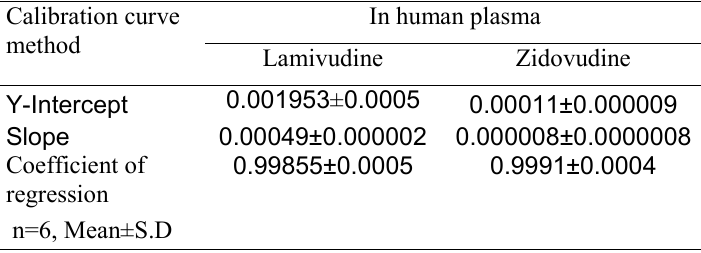
Figure 2. Spectrum for plasma interference with samples and standard. Table 1. Summary of calibration curve